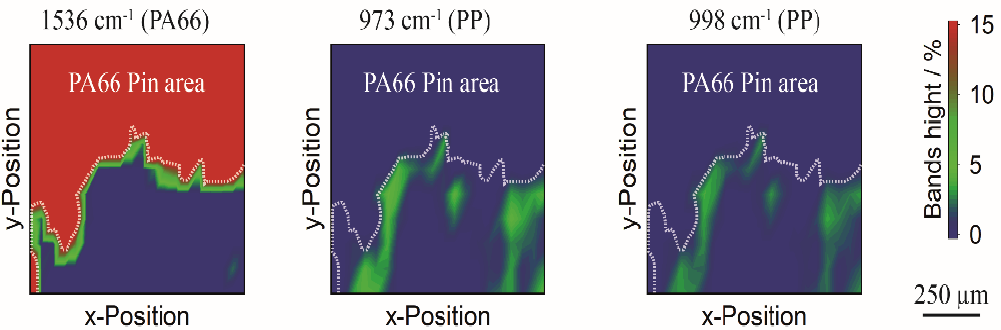
Figure 7. Material detection by FTIR for PA66–PP joint at a thin cut of the structured ‐ partner (PA66) in the area of the cavity between two pin ‐ like structures.